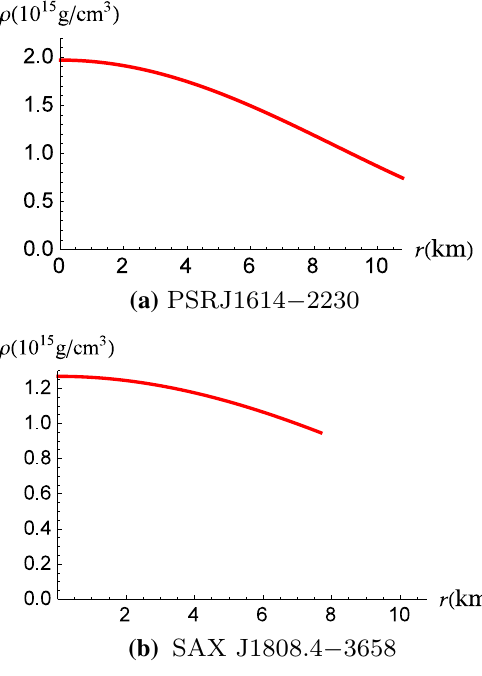
Fig. 3 Variation of tangential and radial pressures verses the radius